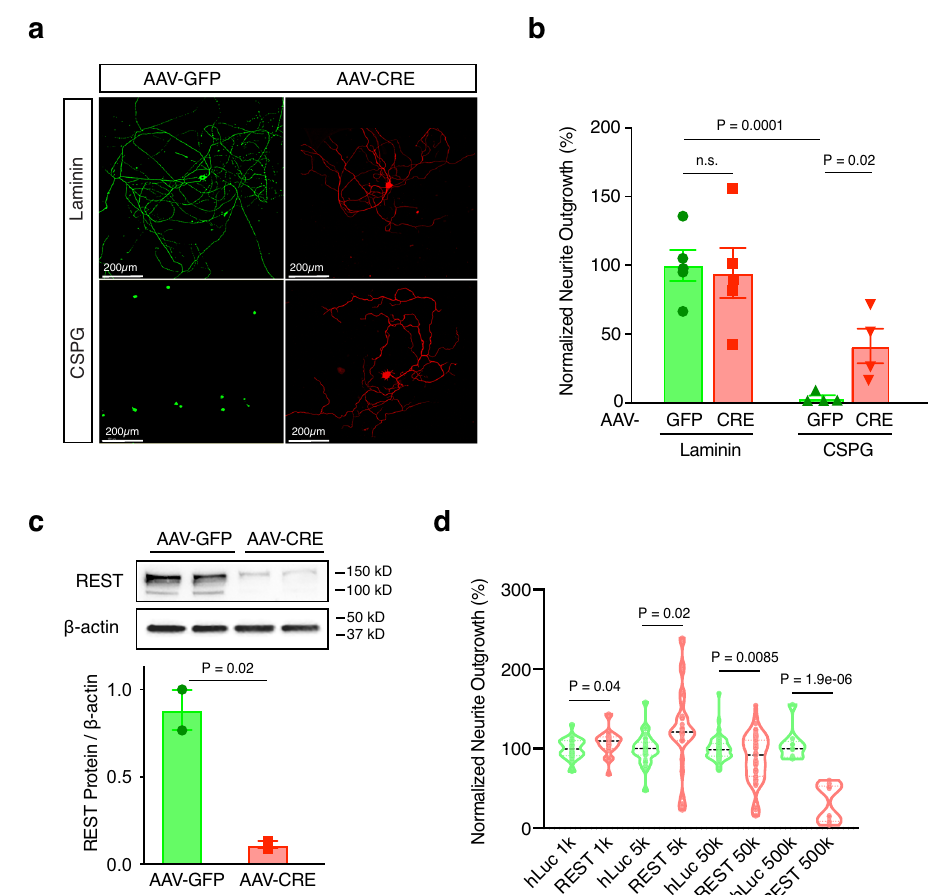
Fig. 6 | REST inhibits neurite growth in vitro. a Tuj1 ( β III tubulin) staining of REST fl x/ fl x ;tdTomato DRG neurons cultured on CSPG (5 µ g/ml) or laminin only (2 µ g/ml) and transduced with AAV-GFP (green) or AAV-CRE (red) at ~100,000 genome copies per cell for 7 days to allow the expression of transgenes. b Quantitation of neurite outgrowth normalized to AAV-GFP infected neurons cultured on laminin. Data are presented as mean neurite outgrowth±SEM. N =3 replicate wells in each condition examined over at least 3 independent experi- ments. c Representative western blot and quantitation of REST levels in DRG cells transduced with AAV-GFP or AAV-CRE. Data are presented as mean±SEM. N